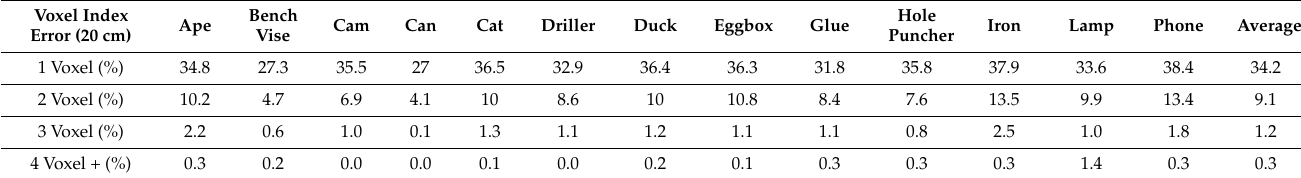
Table 4. Distance error comparison for voxel size (20 cm).